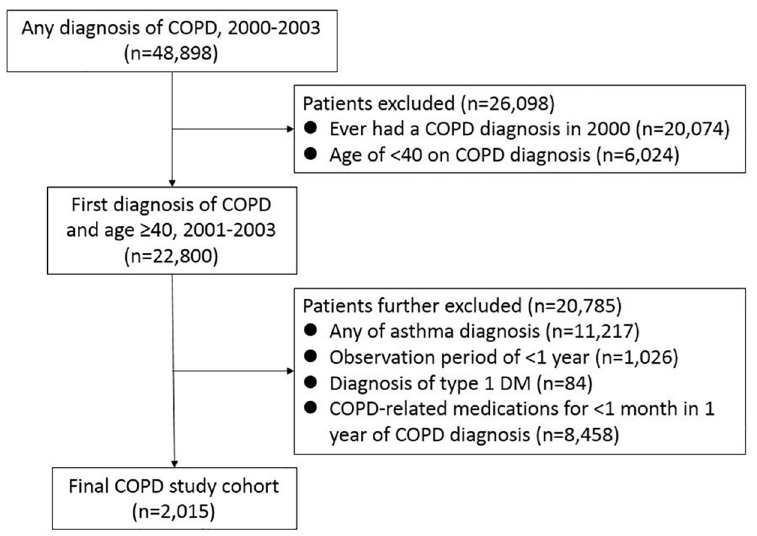
Fig 1. Study flow diagram. COPD, chronicobstructive pulmonarydisease;DM, diabetes mellitus.